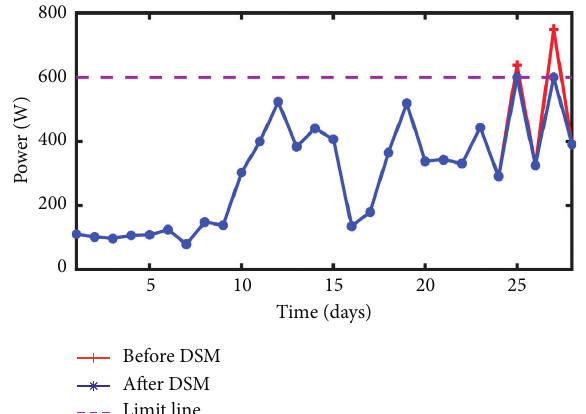
Figure 17: Load profile before and after the implementation of DSM in cluster 8.